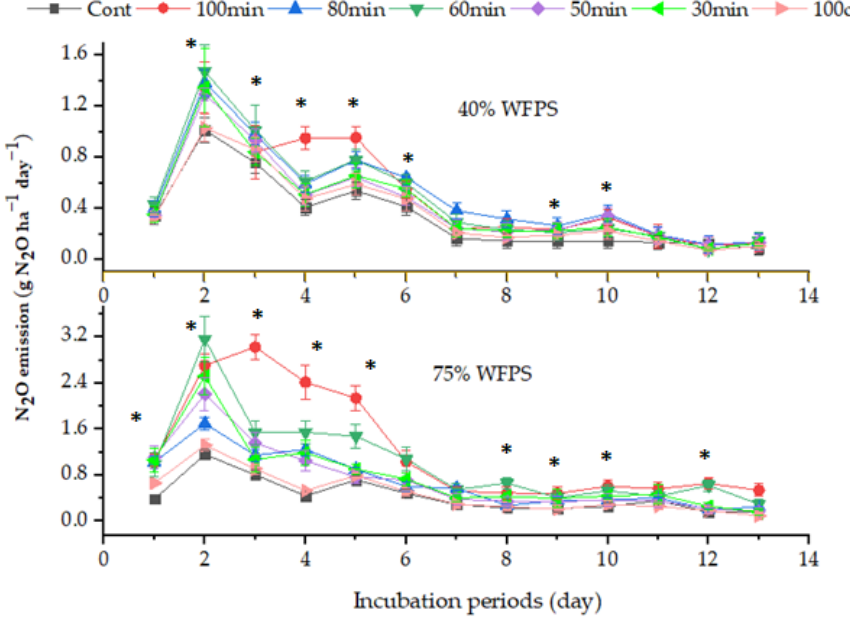
Figure 3. Emissions of nitrous oxide (N 2 O-N) from treatments with different fertilizer types and water-filled pore space (WFPS) (40 and 75%). Cont.: Control (no input); 100 min: 100% mineral fertilizer N (100 kg N ha − 1 ) and P (33.3 kg P ha − 1 ), 80 min: 80% mineral fertilizer + 1.4 t ha − 1 compost; 60 min: 60% mineral fertilizer + 2.8 t ha − 1 compost; 50 min: 50% mineral fertilizer + 3.5 t ha − 1 compost; 30 min: 30% mineral fertilizer + 4.9 t ha − 1 compost, and 100comp: 100% compost (7 t ha − 1 compost).* indicates significant differences among the treatments (Tukey HSD test, p < 0.05). Error bars indi- cate the standard error of the mean (n = 3).